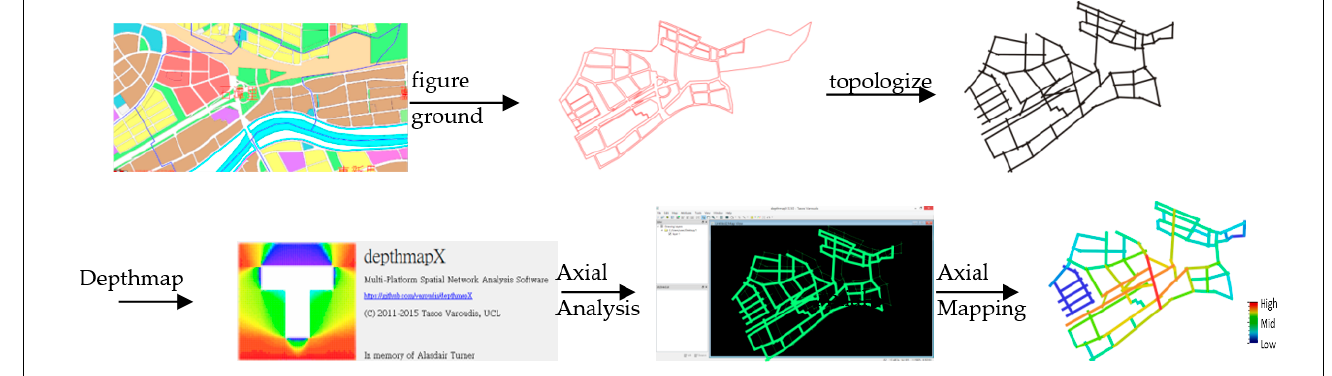
Figure 3. Software operation example 371